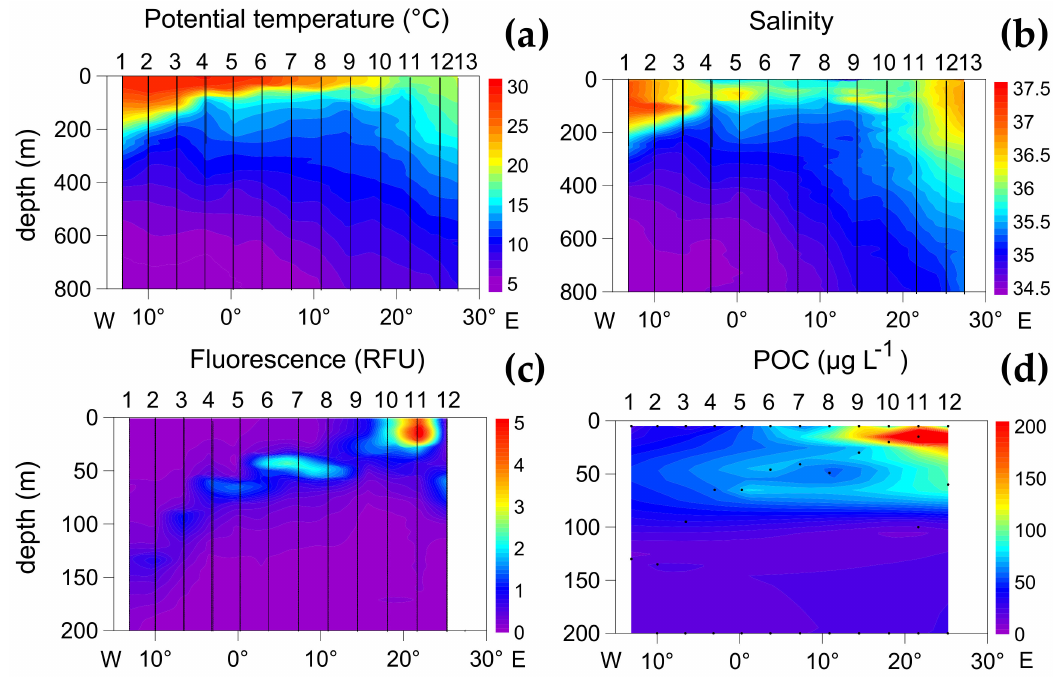
Figure 2. The surface to 800 m sections of potential temperature ( ◦ C) ( a ), salinity ( b ), surface to 200 m profiles of fluorescence (RFU: relative fluorescence units) ( c ) and particulate organic carbon (POC, µ g L − 1 ) ( d ). Station numbers are indicated in the upper axis of each